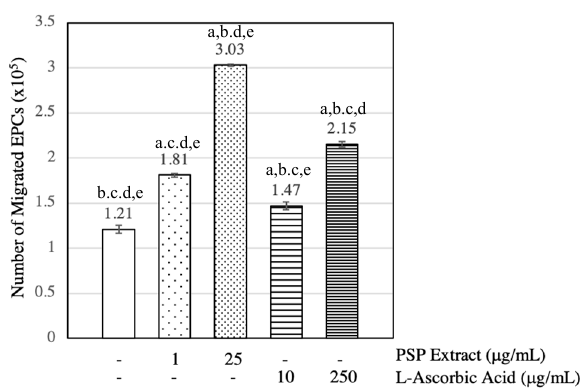
Figure 2. PSP extract and L -ascorbic acid induced EPCs migration. EPCs were cultured in Boyden chambers as described in Materials and Methods, EPCs were induced with/without 1 μ g/mL PSP extract, 25 μ g/mL PSP extract, 10 μ g/mL L -ascorbic acid or 250 μ g/mL L -ascorbic acid for 48 h. Sextuplicate was performed for each group. a: Significant difference compared to the untreated group ( p < 0.001), b: Significant difference compared to the 1 μ g/mL PSP extract group ( p < 0.001), c: Significant difference compared to the 25 μ g/mL PSP extract group ( p < 0.001), d: Significant difference compared to the 10 μ g/mL L -ascorbic acid group ( p < 0.001) and e: Significant difference compared to the 250 μ g/mL L -ascorbic acid group ( p < 0.001).